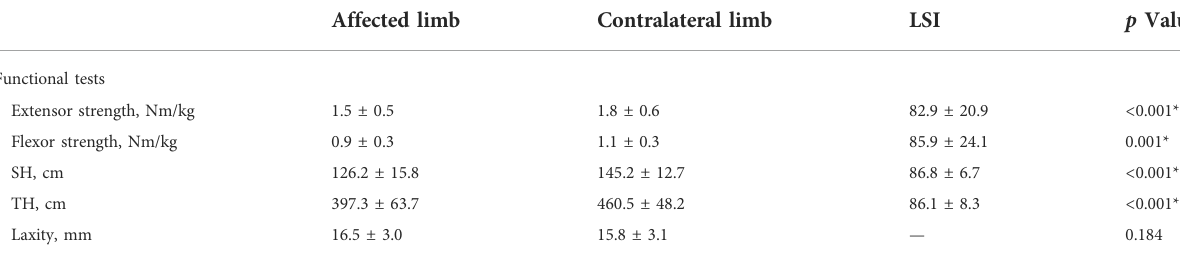
TABLE 2 Functional parameters outcomes a .